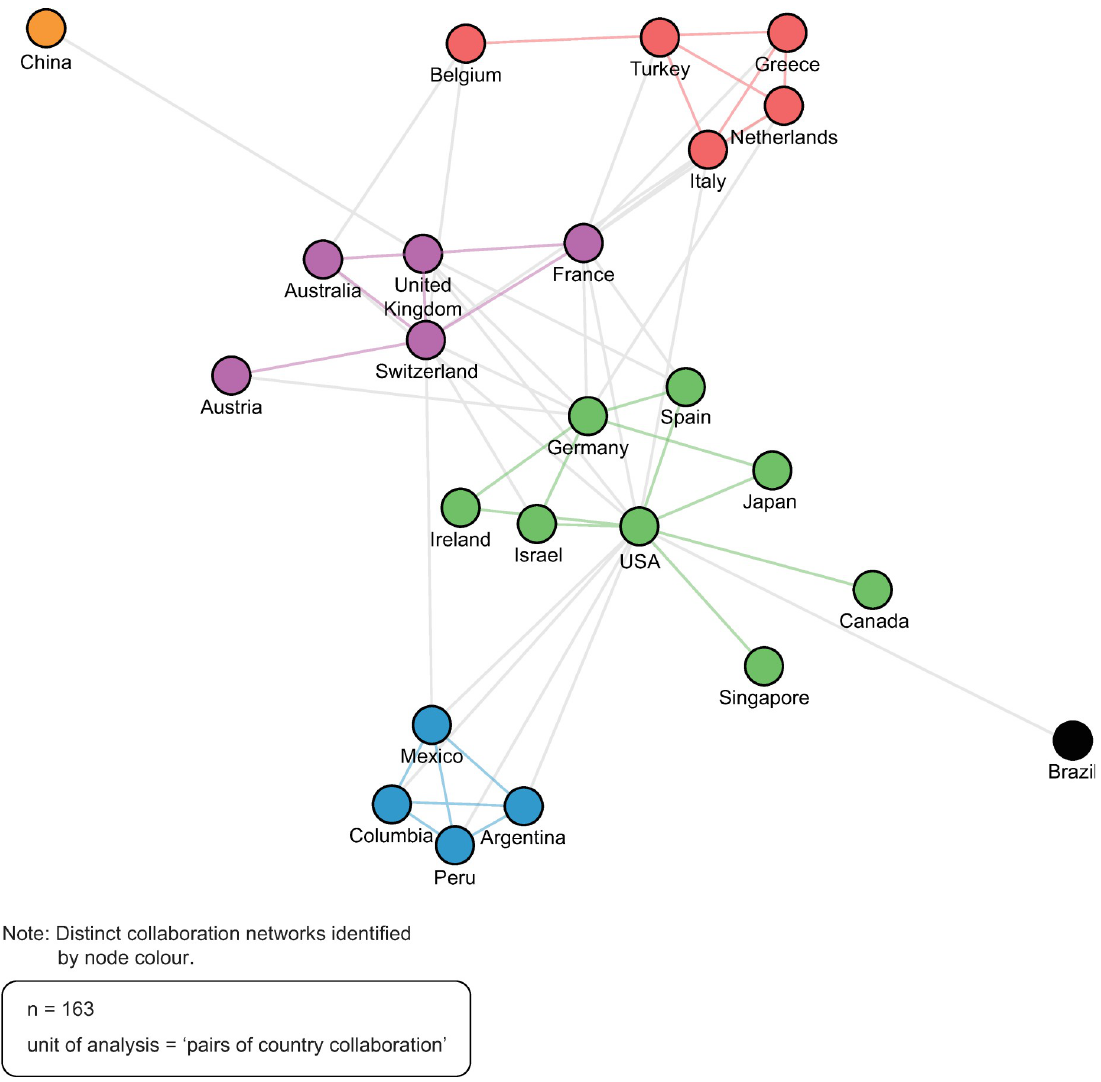
Fig 7. Country collaboration networks. Source: R-based application Biblioshiny was used; visualization was recreated using Adobe Illustrator. Parameters specified: network layout = automatic layout (default); clustering algorithm = walktrap (default); normalization = association (default); number of nodes = 2000; repulsion force = 0.1 (default); remove isolated nodes = yes (default); minimum number of edges (i.e., connections) = 1 (default).